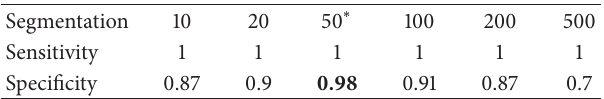
Figure 7: Upper/lower thresholds and acceleration time serials of normal/rub-impact rotor. Table 1: Pedestal looseness detection rate of different segmentation strategies.